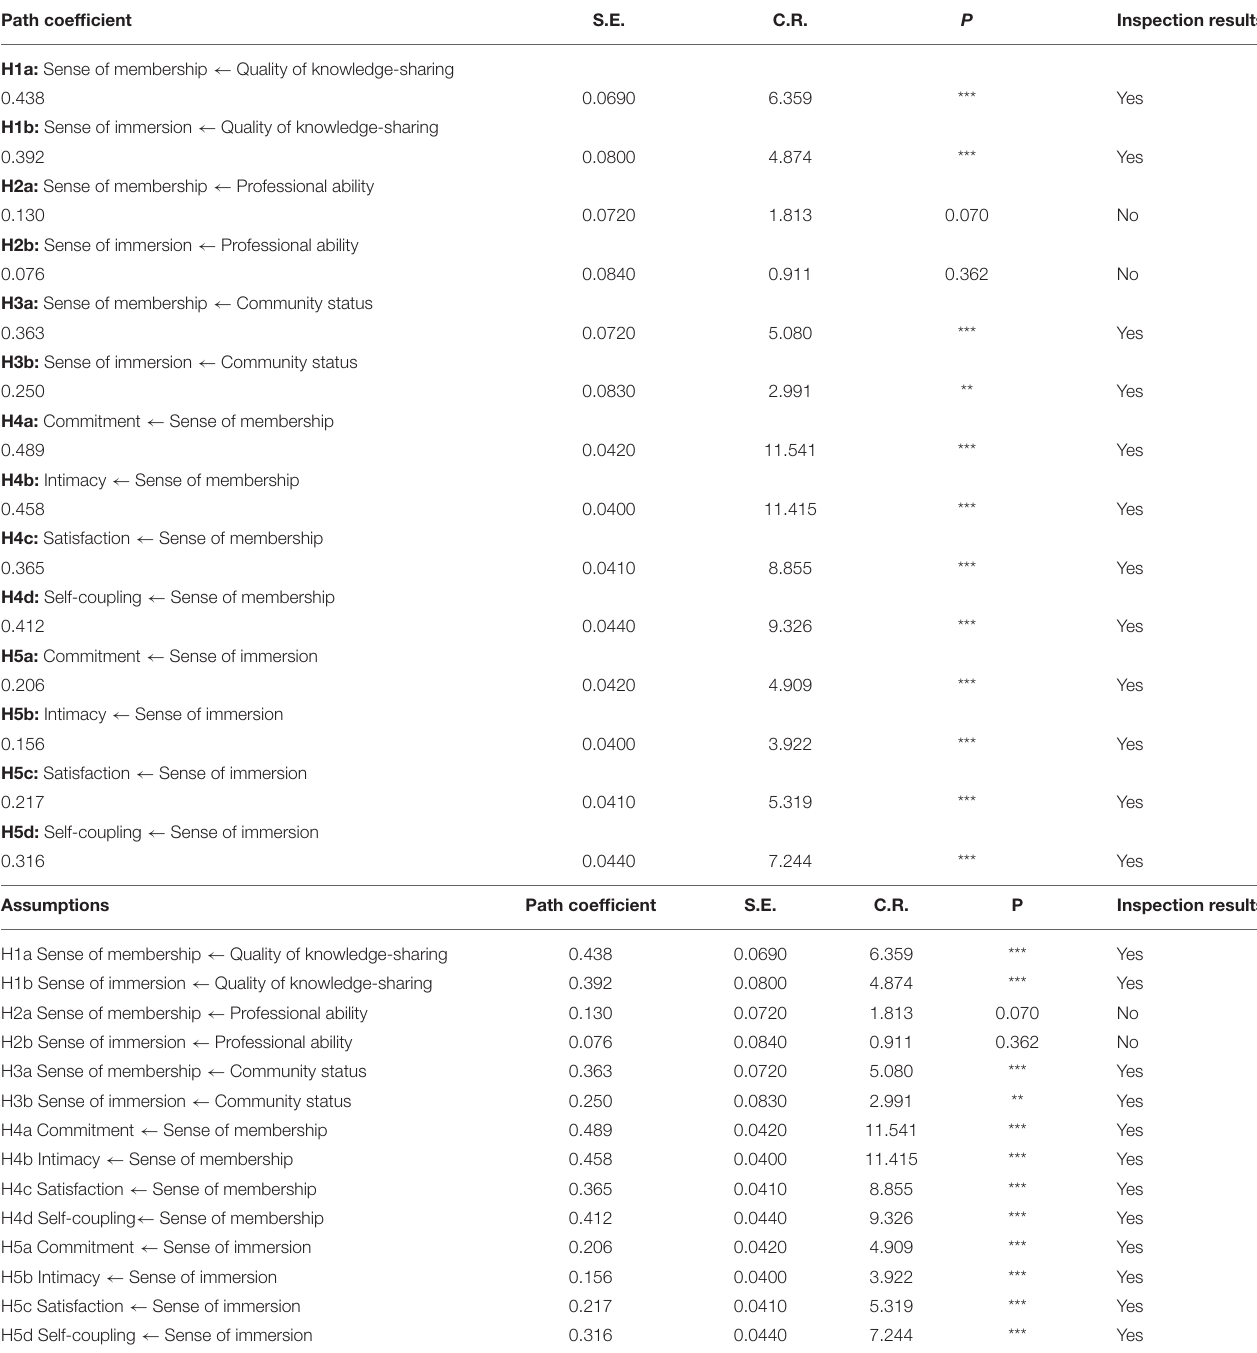
TABLE 4 | Significance test of path